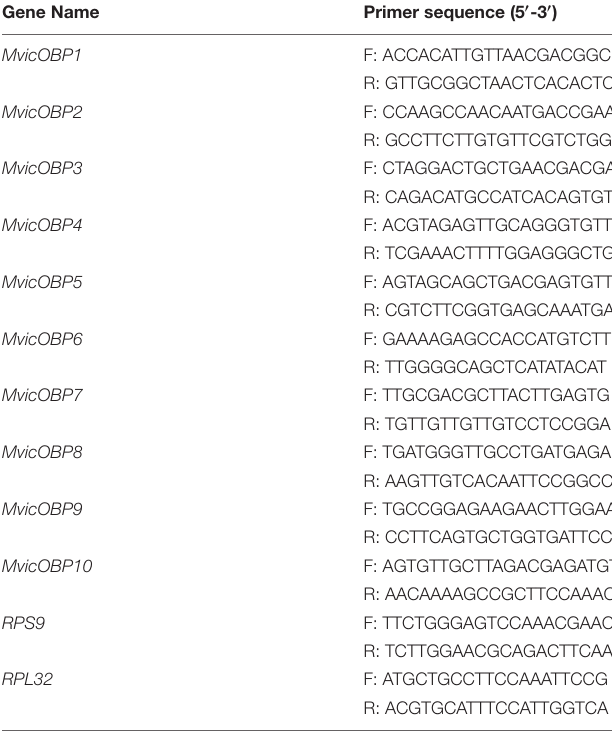
TABLE 1 | Primers used for